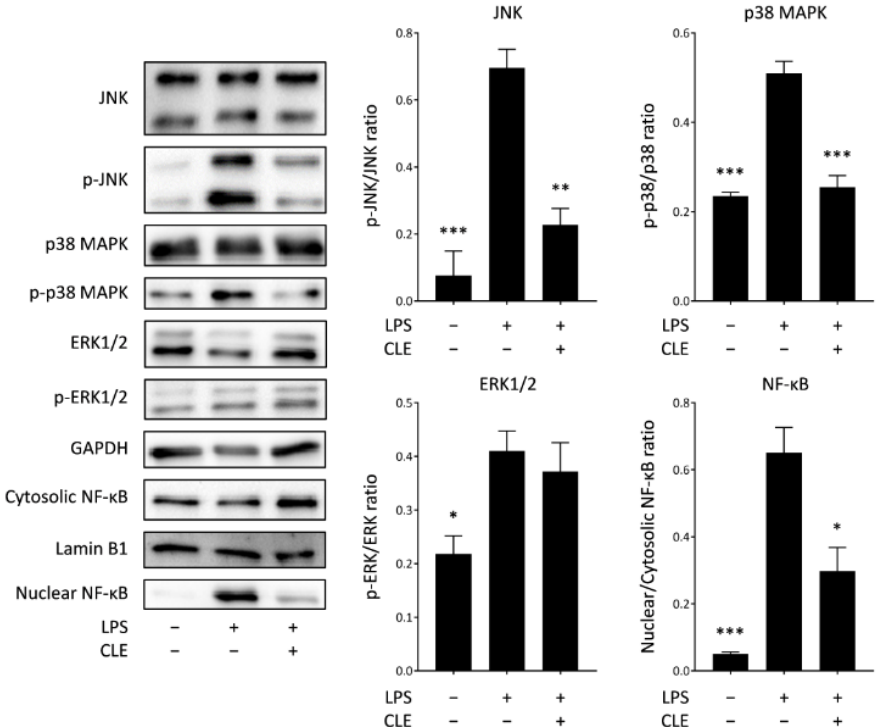
Figure 6. Effect of an aqueous extract from leaves of Citrus unshiu (CLE) on intracellular signaling pathways in RAW 264.7 cells. RAW 264.7 cells were treated with 1.25 mg/mL of CLE for 24 h, followed by LPS stimulation for 15 min. Then, the phosphorylation levels of ERK, JNK, and p38 MAPK and nuclear translocation level of NF- κ B were evaluated by immunoblot analysis. A representative blot from three independent experiments is shown. The result of densitometric analysis is expressed as the ratio of phosphorylated protein amount to whole protein amount or of nuclear protein amount to cytosolic protein amount. Data are represented as mean ± SEM of three independent experiments. * p < 0.05, ** p < 0.01, or *** p < 0.001 against control (LPS positive/CLE negative) by Dunnett’s test.